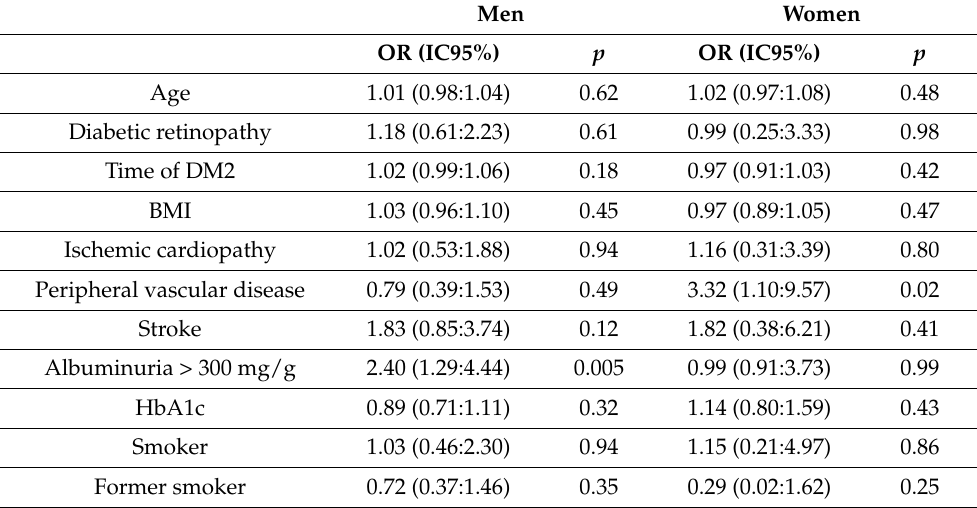
Table 3. Risk factors for rapid deterioration of kidney function by sex.